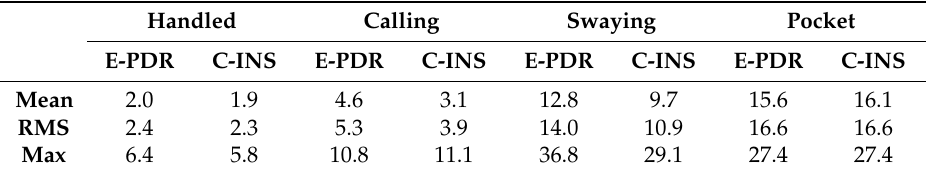
Figure 7. Heading angle cumulative error percentages of E-PDR and C-INS solutions for four different phone-holding positions. Table 1. Heading angle error of E-PDR and C-INS solution for four different phone-holding positions (units of